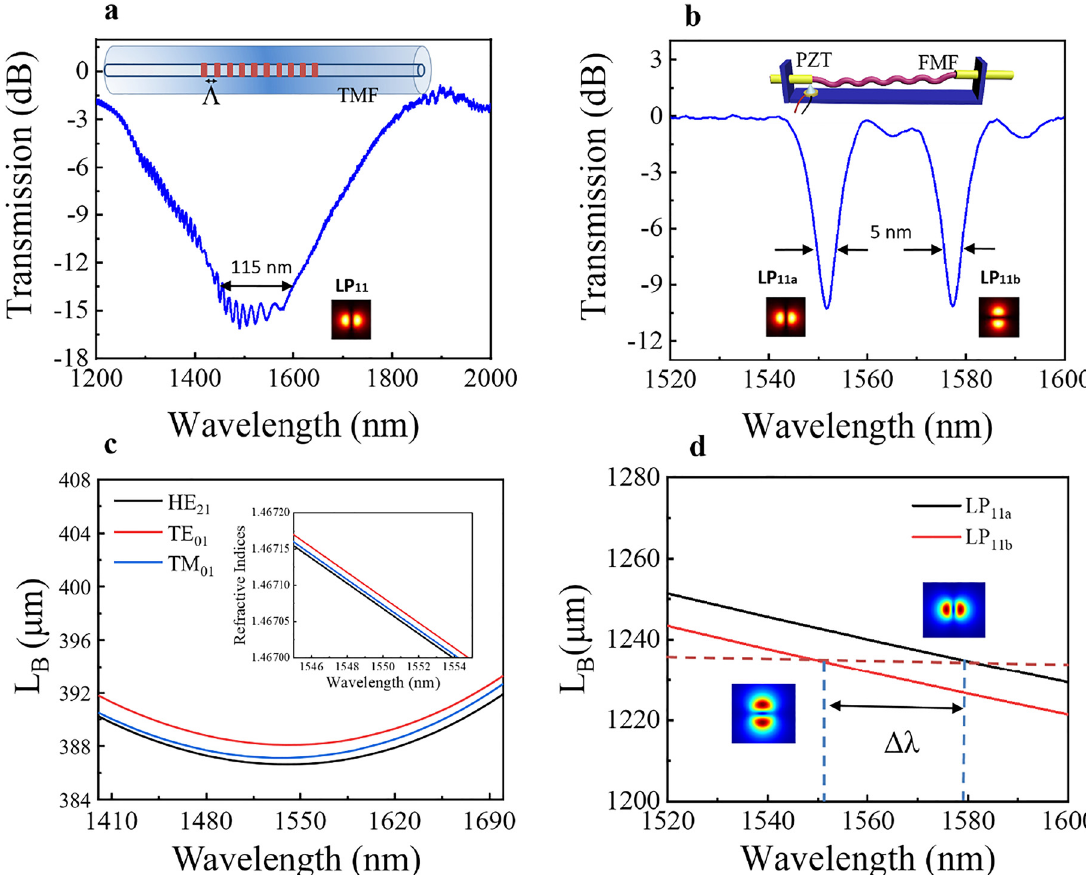
Figure 2: Transmission spectra and phase-matching curves for a TAP-LPFG and an AIFG. (a)BroadbandmodeconversionandtheinsetisaschematicdiagramofTAP-LPFG.(c)BeatlengthofLP 11 eigenmodes(HE 21 ,TE 01 ,andTM 01 )and the inset is refractive indices dependent on the wavelength. (b) Dual-resonant wavelengths in the transmission spectrum of an AIFG and the inset is the schematic diagram of the AIFG. (d) Beat length of LP 11a and LP 11b